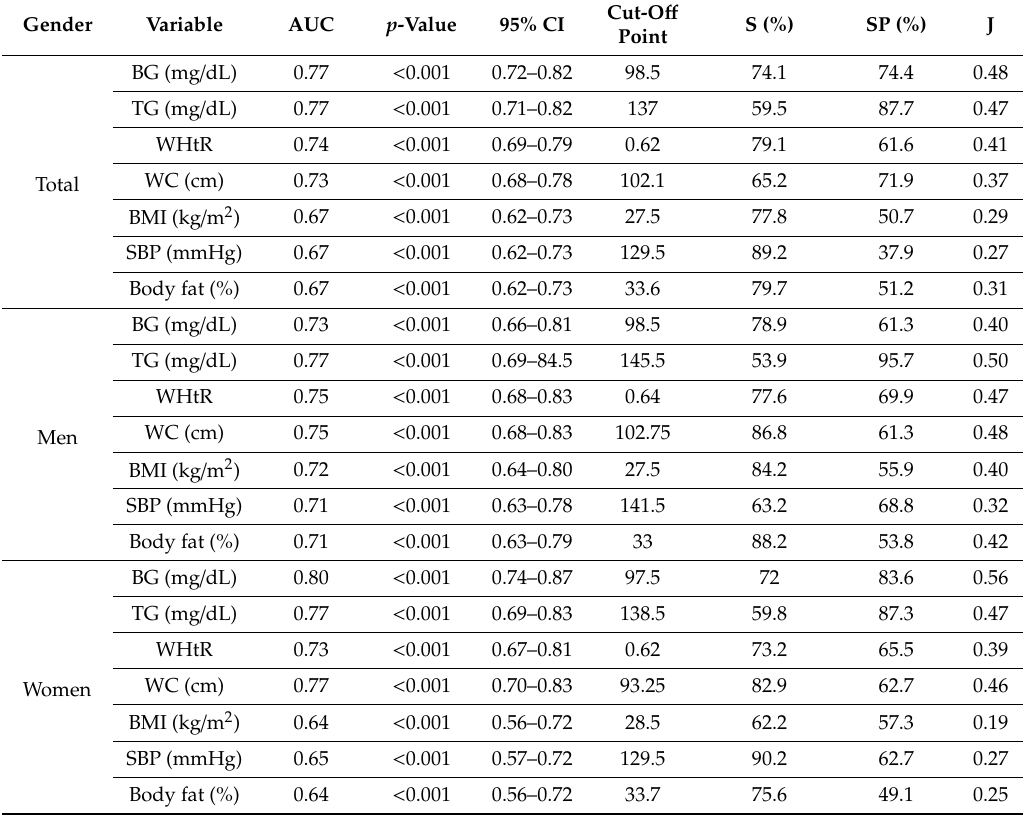
Table 2. Diagnostic accuracy of predictive variables for MetS in the elderly population ( n = 158). Total sample and according to gender.